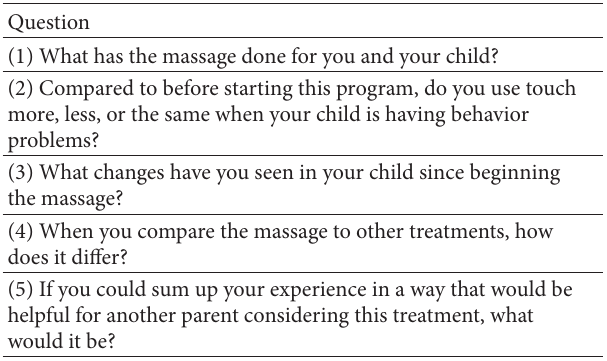
Table 2: Parent posttreatment